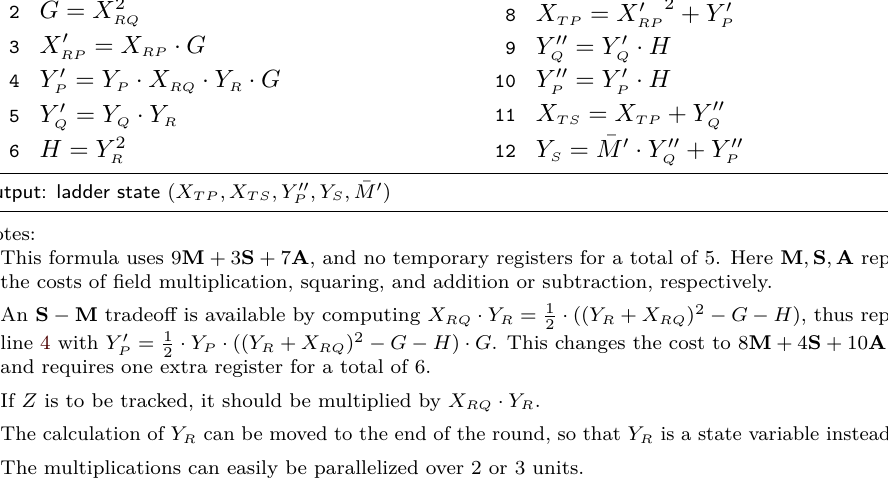
Figure 5: Improved Joye